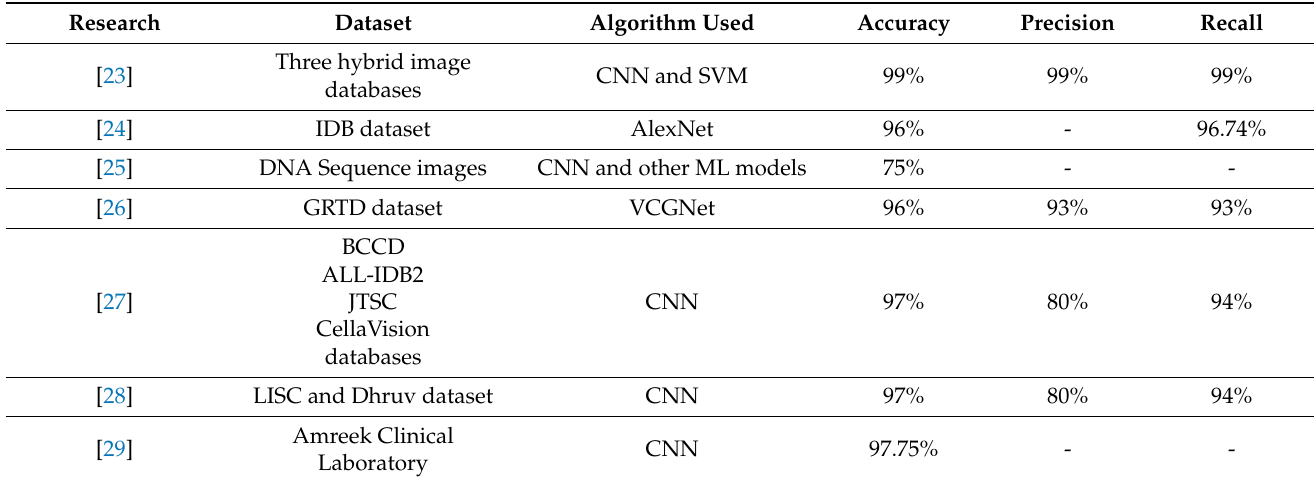
Table 1. Existing research that diagnoses ALL using deep learning.